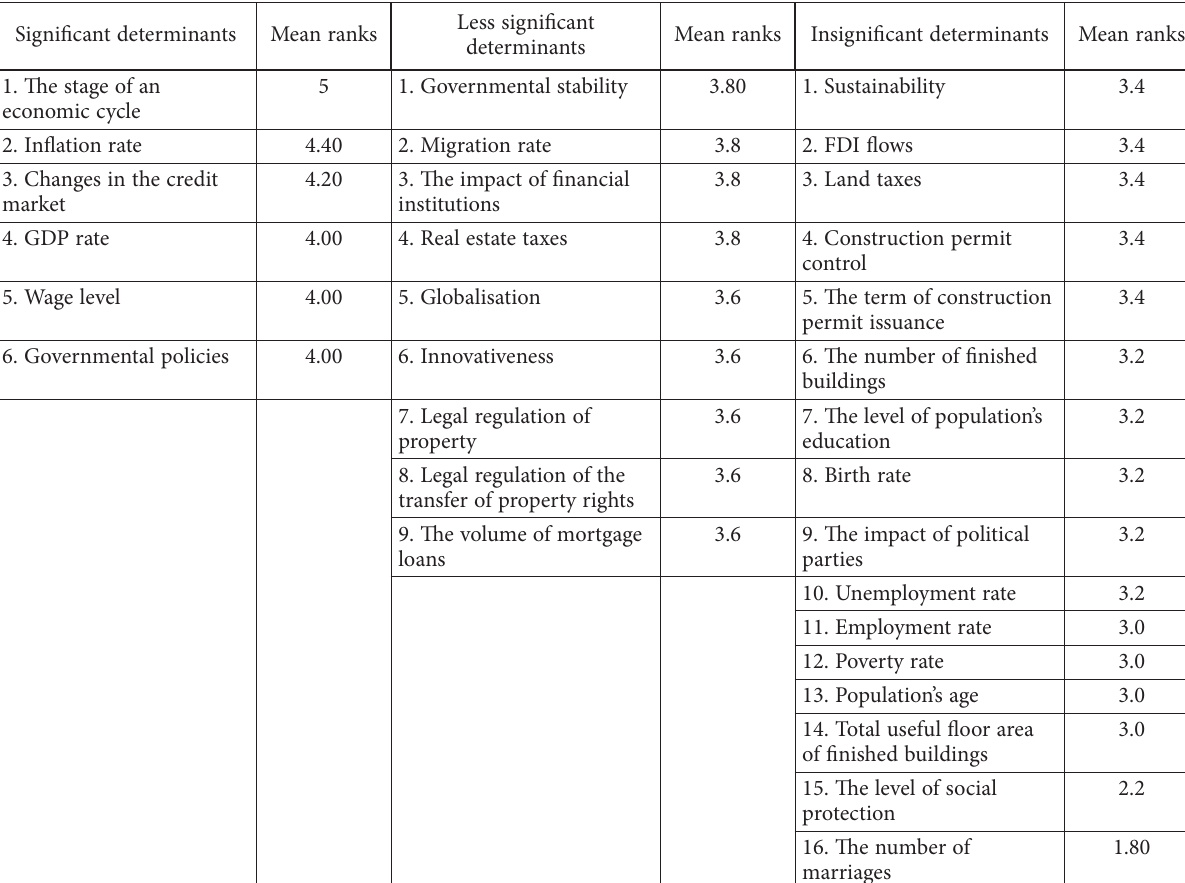
Table 3. The general determinants of the value of land by their